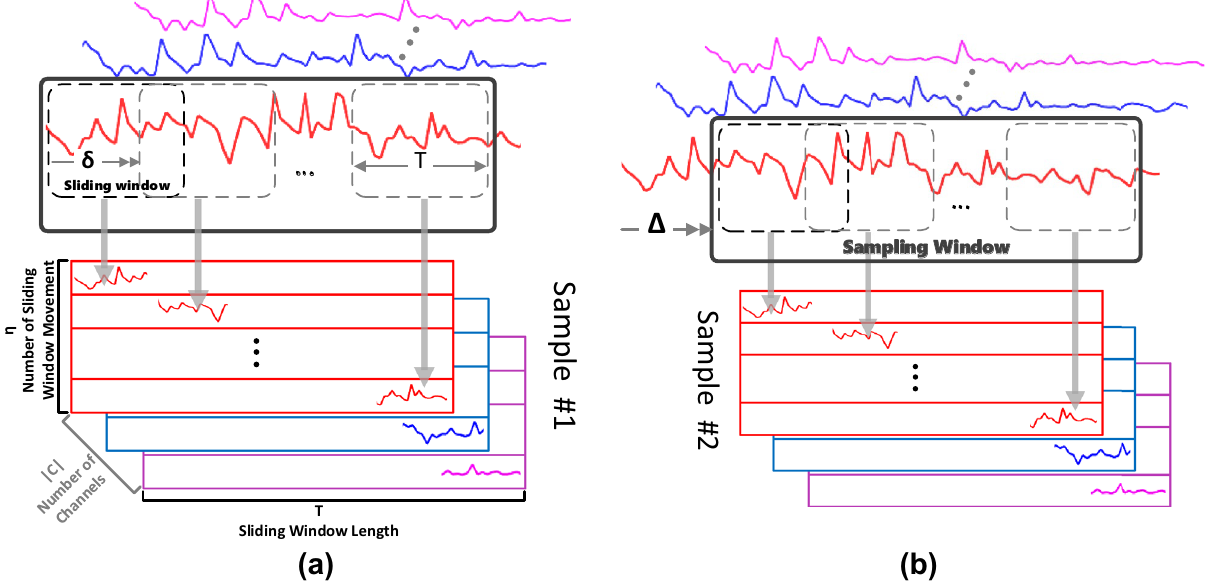
Figure 3. Sampling and sliding window mechanisms to generate input data of CNN from EEG time-series